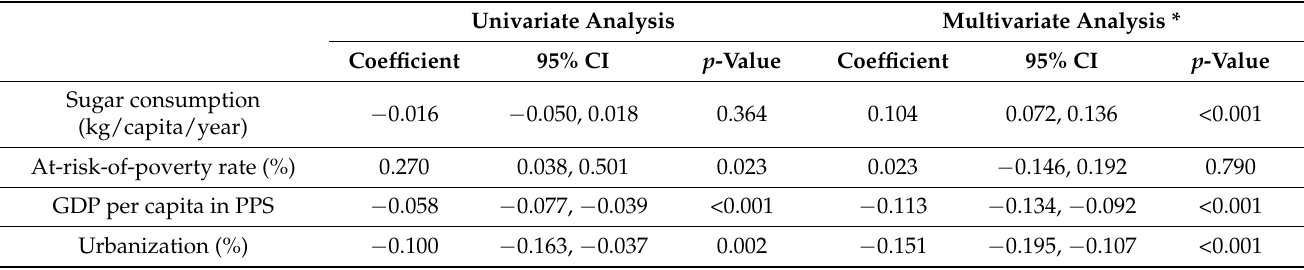
Table 2. Panel data regression models for the effect of sugar consumption, at-risk-of-poverty rate, GDP per capita, and urbanization on YLDs rate of early childhood caries over time